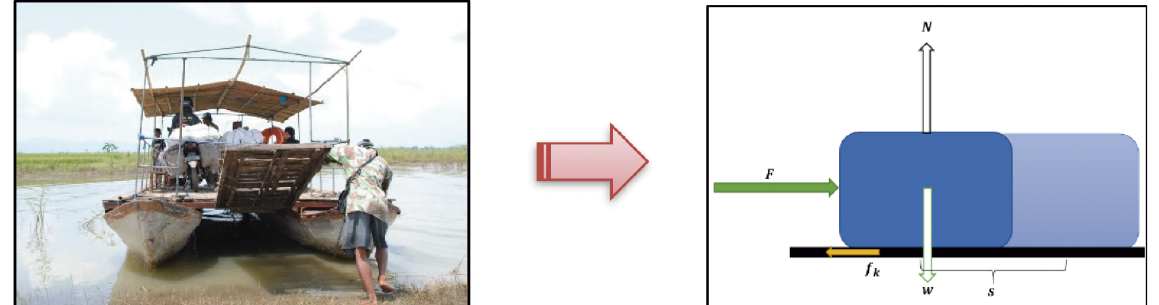
Figure 1. The concept of work in the phenomenon of a fisherman pushing a boat